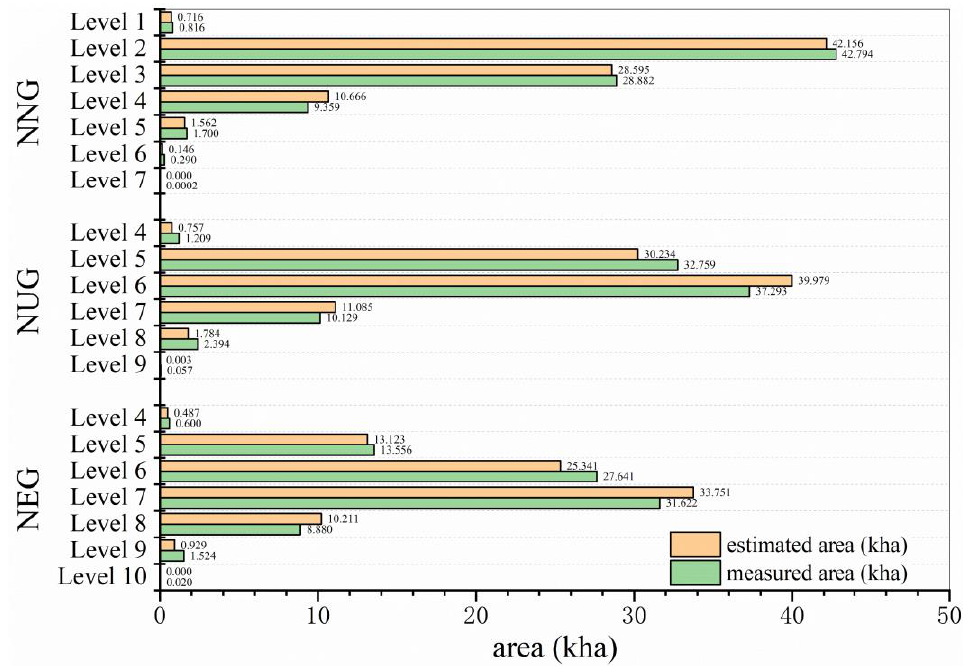
Figure 7. Comparison of the measured and estimated areas of cultivated land quality.